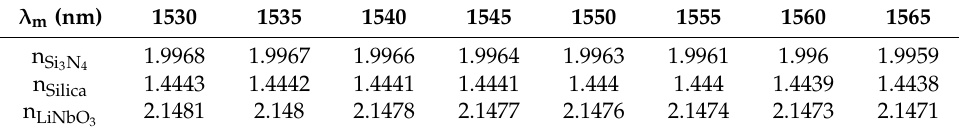
Table 1. The multicore photonic crystal fiber (PCF) materials’ reflective index values.